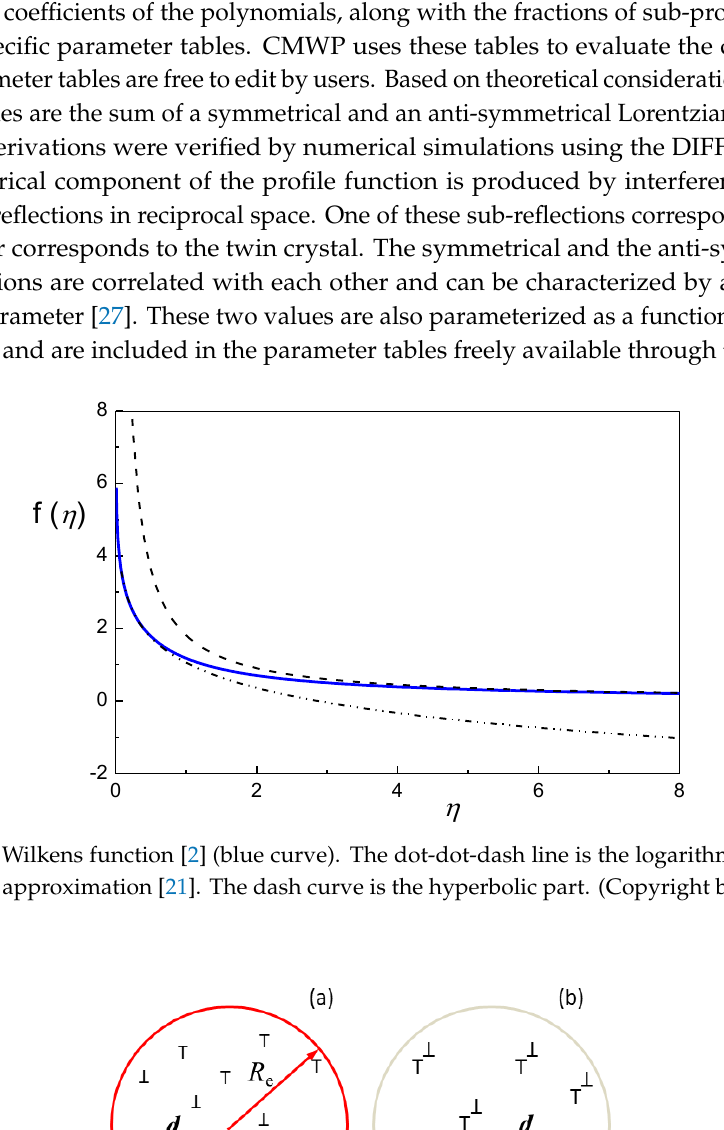
Figure 2. An intuitive schematic interpretation of the dislocation dipole character parameter, M = R e √ . ( a ) Random dislocation distribution, where M (cid:105)(cid:105) 1. ( b ) Dislocations arranged in strong dipole configuration where M (cid:104)(cid:104) 1. The size of the regions of the material in ( a ) (red circle) and ( b ) (gray circle) and the number of plus and minus dislocations (up and down Ts) in the two regions are the same. The red arrows are for Re and the blue double arrows are for the average dislocation distance.